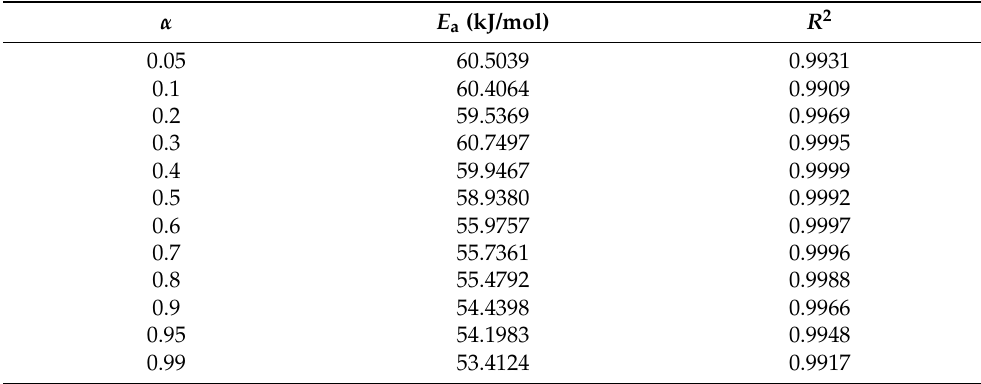
Figure 10. In the DSC experiment, when β is equal to 1, 2, 4, 7, and 10 ◦ C/min, differential isoconver- sional analysis of LP30 + PFPN under the FWO model. Table 4. E a and R 2 under different α based on the FWO